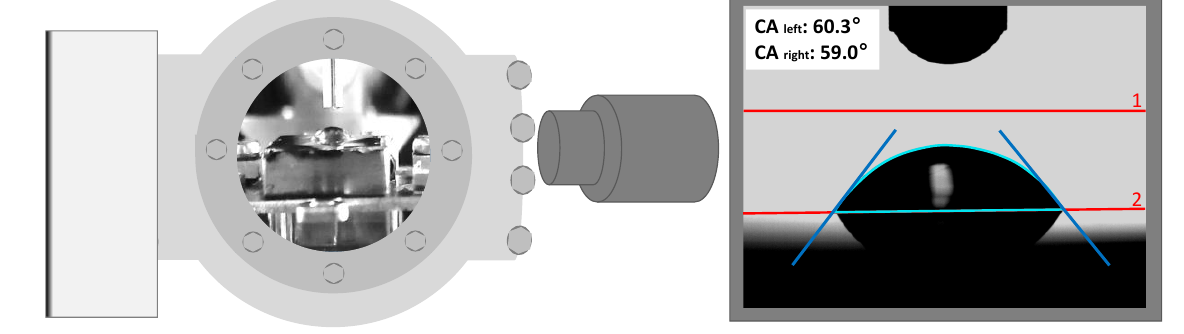
Figure 6. Left: Schematic representation of the SD configuration for interface tension measurements with the diffuse light source (left), chamber with sessile drop (middle) and camera (right). Right: Image of a sessile drop of [C 8 C 1 Im][PF 6 ] placed at room temperature under vacuum conditions on carbon-contaminated stainless-steel with the manually set reference lines in red (1: boundary line, 2: base line). From the software-derived contour line (turquoise) with its tangents (blue), the values for the left and the right contact angle are deduced.